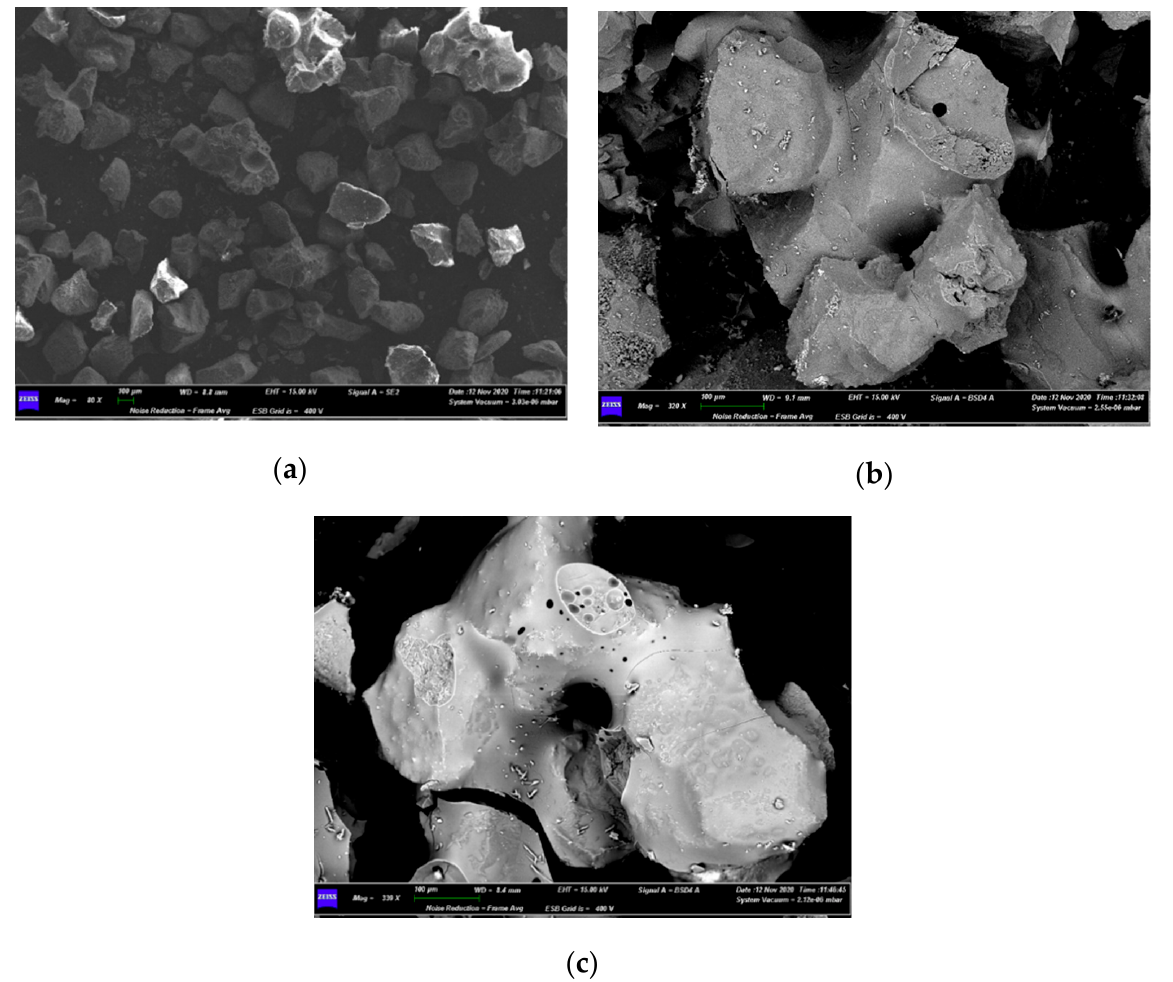
Figure 9. SEM micrographs of the coarse agglomerates from the spent sand bed after the last test, magnified at: 80× ( a ); 320× ( b ); 339× ( c ).